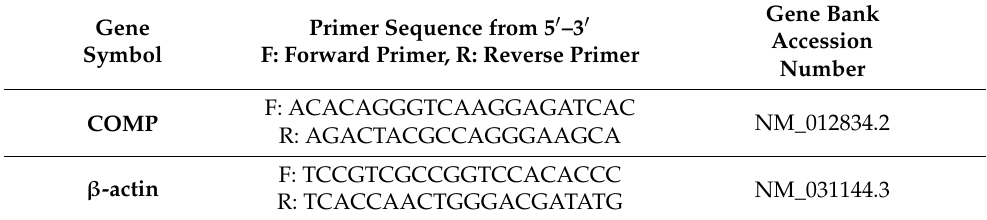
Table 3. Primer sequence of all studied